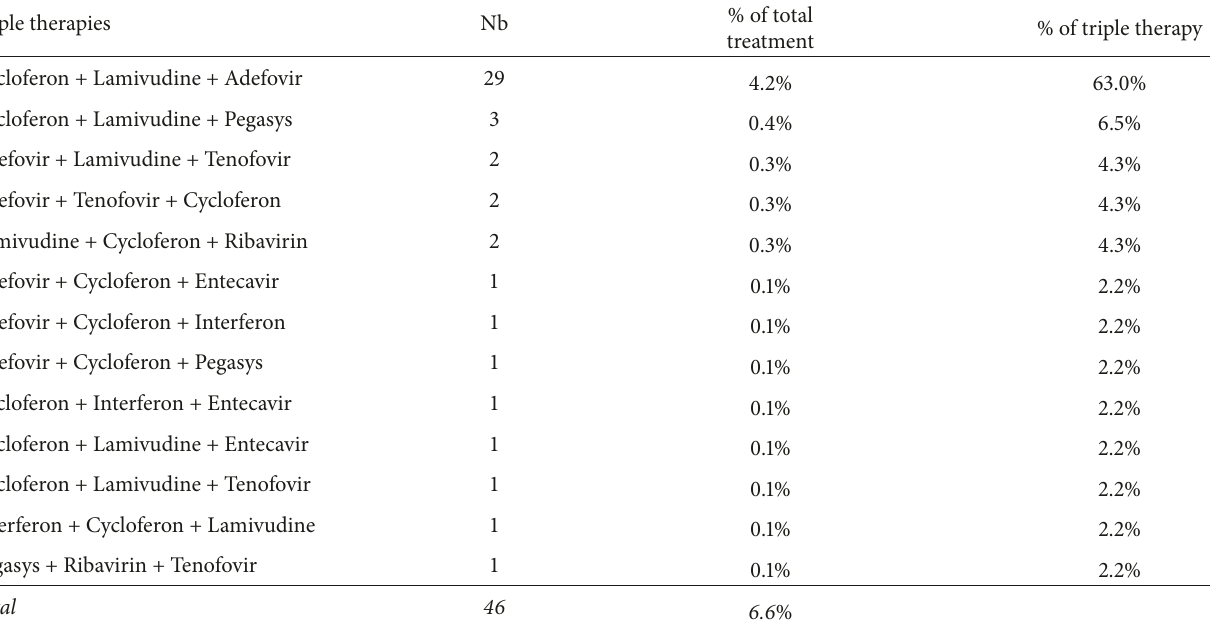
Table 2: Type of drugs, number, and % on total and triple